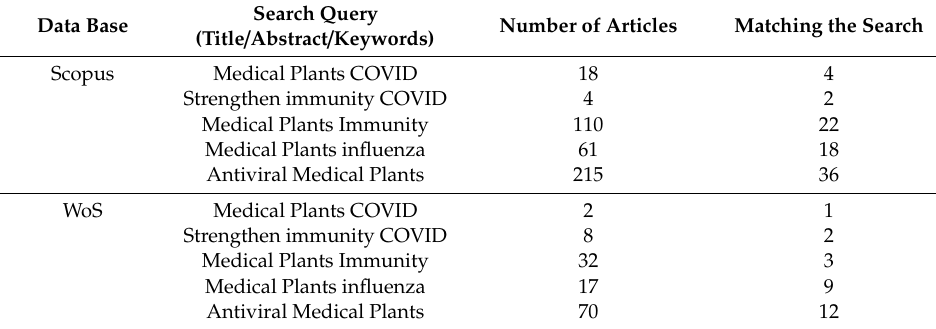
Table 1. Strategies for finding literary sources of the